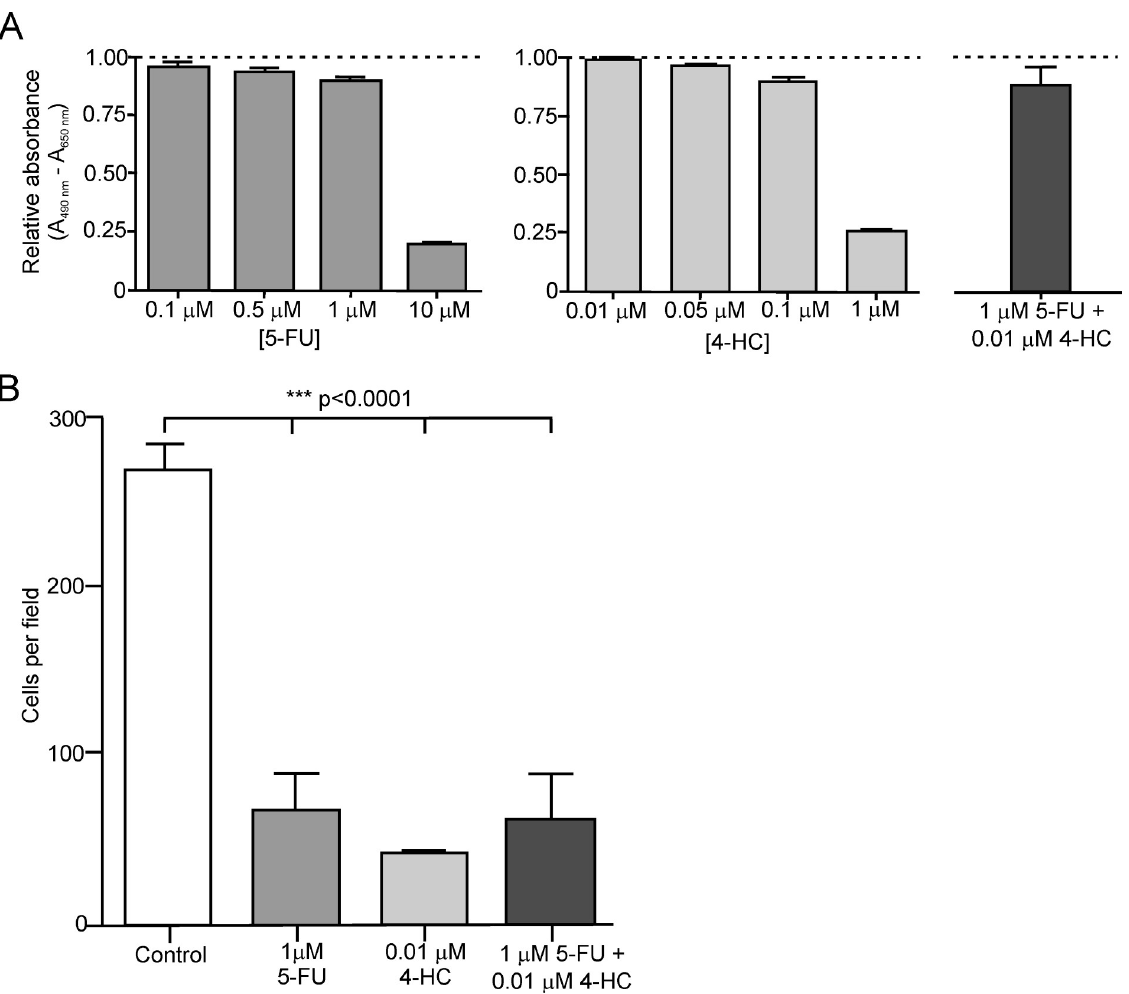
Fig 9. Effect of continuous exposure to 5-FU, 4-HC and 5-FU+4-HC on viability and invasiveness of 231/LM2-4 cells. (A) Effect of prolonged continuous exposures (six days) to different concentrations of 5-FU (0.1, 0.5, 1 and 10 μ M), 4-HC (0.01, 0.05, 0.1 and 1 μ M), and to the combination 1 μ M 5-FU + 0.01 μ M 4-HC, on in vitro viability of 231/LM2-4 cells. The relative absorbance (A 490nm -A 650nm ) to control is represented; A 490nm is directly proportional to the number of living cells and A 650nm eliminates any kind of background. (B) Assessment of the invasive capacity of 231/LM2-4 cells, under untreated and treated conditions, in a transwell chemoinvasion assay using collagen type IV as coating. The protracted treatments with low dose and non-toxic doses of 1 μ M 5-FU, 0.01 μ M 4-HC and the 1 μ M 5-FU + 0.01 μ M 4-HC combination are detailed in Materials and methods. Cells that invaded and passed through membrane pores were stained with 0.1% crystal violet and counted. The numbers are the mean ± standard error of the mean (SEM), of the cell counts of eight random fields (x20 magnification) per sample of a representative experiment. The experiment was repeated three times. A significant reduction in invasive capacity of the cells was observed in all treated groups ( ��� p < 0.0001 vs . control). Significance was analyzed by one-way ANOVA with Dunnett’s